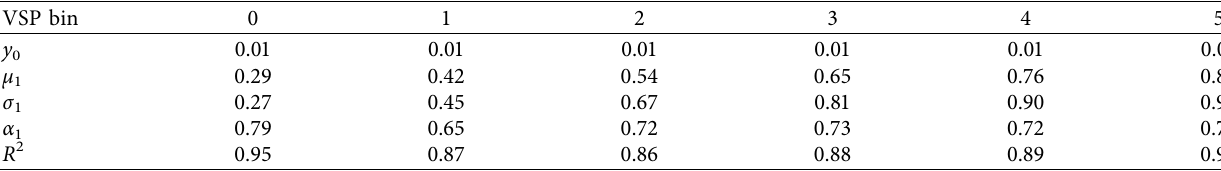
Table 1: Gaussian distribution ftting parameters for CV VSP bins.